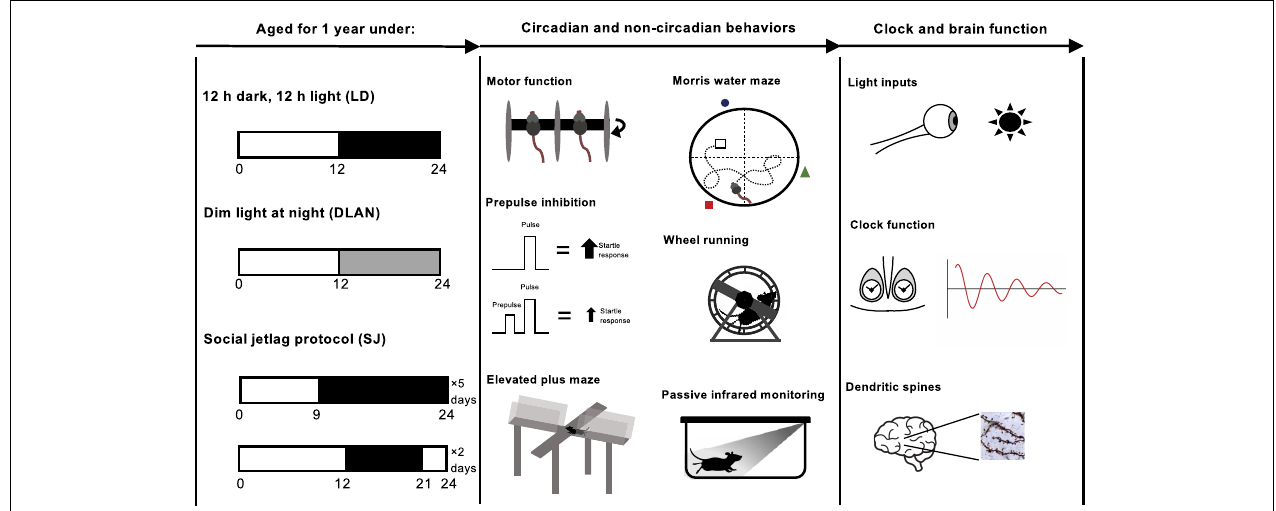
FIGURE 1 | Experimental protocol for the aging of mice over the span of 1 year, under different lighting conditions followed by mouse phenotyping. Starting at ∼ 8 weeks of age, mice were left to habituate to the light-proof cabinets. Then, at ∼ 10 weeks old, mice were subjected to one of the following three abnormal lighting condition for 12 months (i.e., until ∼ 62 weeks old): (1) standard 12:12 light-dark cycles (light at ∼ 200 lux) (LD group, control); (2) 12:12 light cycles in which the dark phase is replaced by one of dim light (light phase light at ∼ 200 lux, dim light at ∼ 20 lux) (dim light at night (DLAN) group); (3) an environment of 5 days 9:15 L:D and 2 days 15:9 L:D per week (social jetlag (SJ) group). Following the 12-month chronic disruption period, mice were returned to standard 12:12 LD cycles for at least 2 weeks prior to